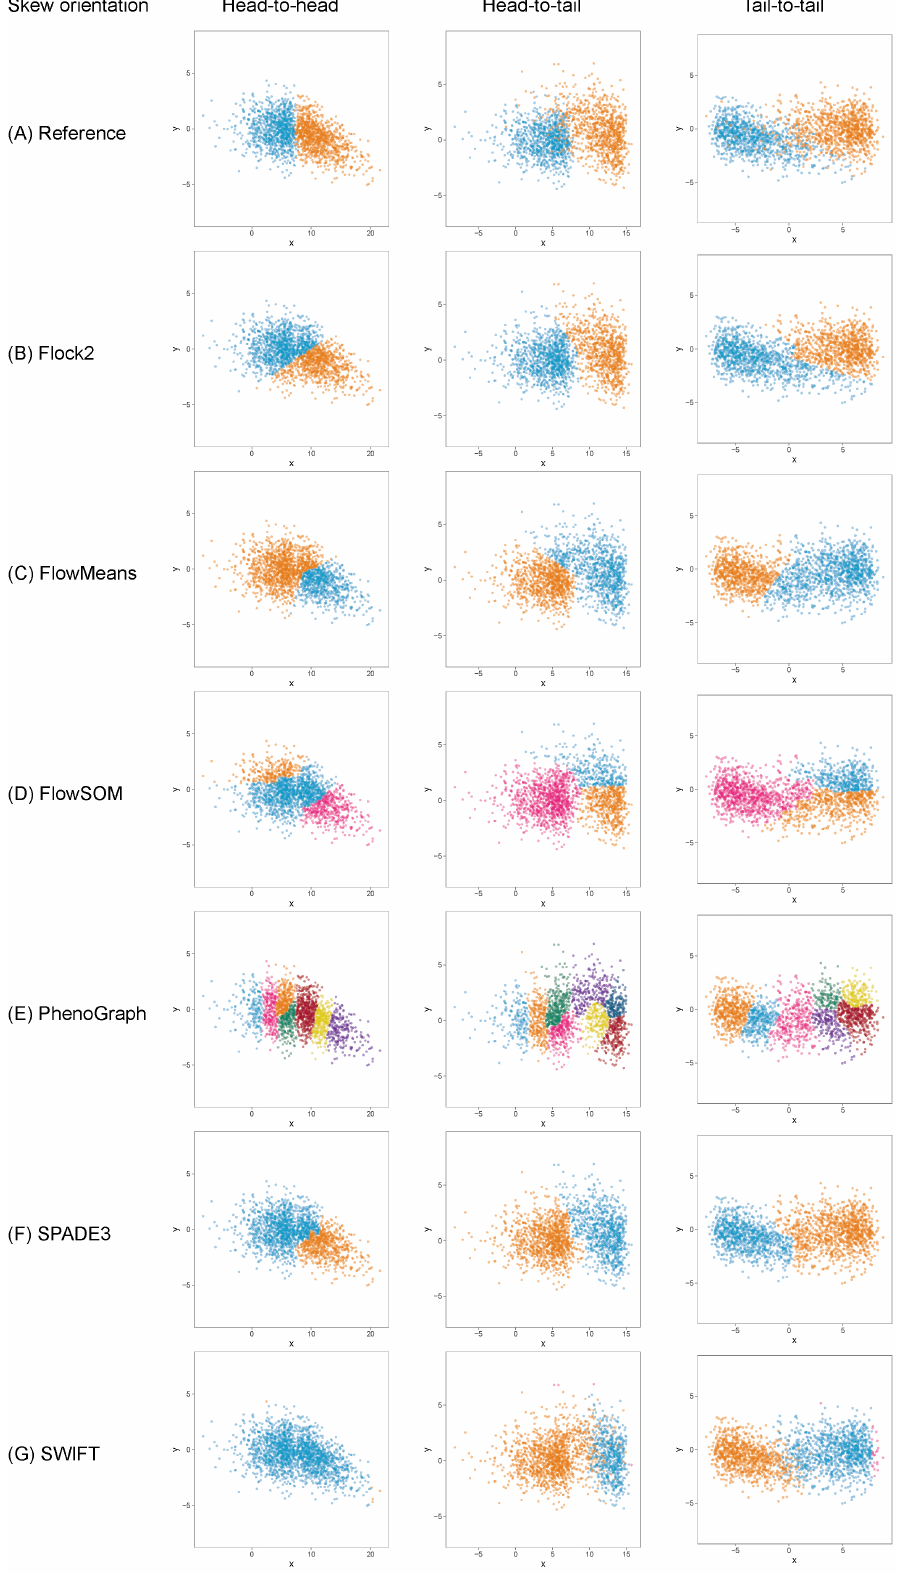
Figure 8. Clustering examples from different software on a two-cluster dataset with skew pairs facing different orientations. All clusters shown with heavy skew ( α =